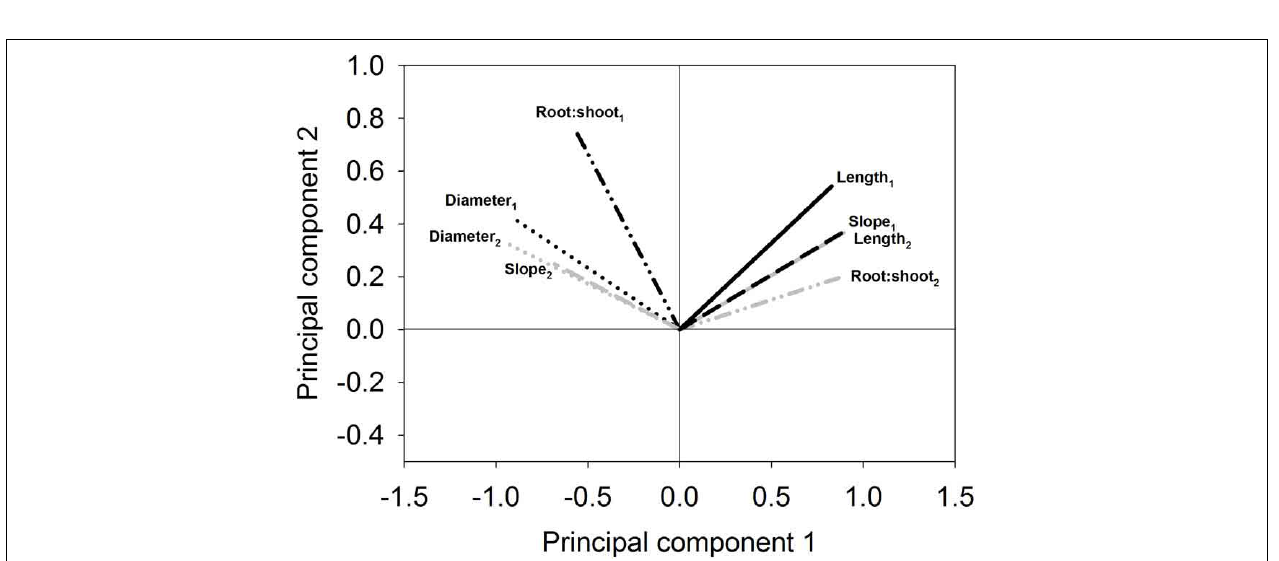
characterization (Data from species experiment, cf. Measured Root System Morphology; Root:shoot is root-to-shoot dry matter ratio; mass, length and diameter ratio are indicators of lateral distribution calculated by dividing the respective parameter measured in and between plant rows).